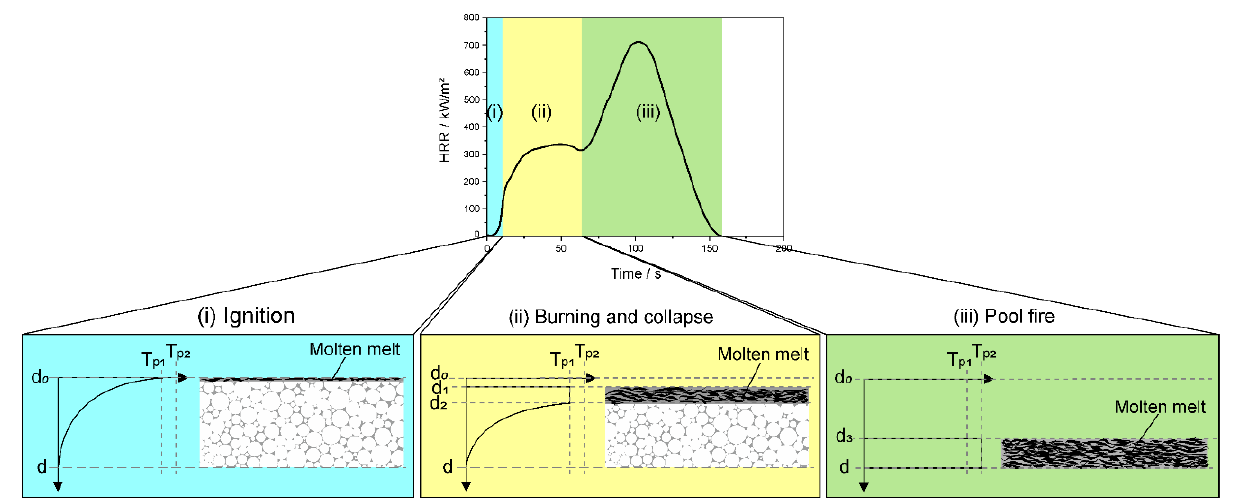
Figure 2. Temperature–thickness relationship of flexible polyurethane foams during different burn- ing stages.